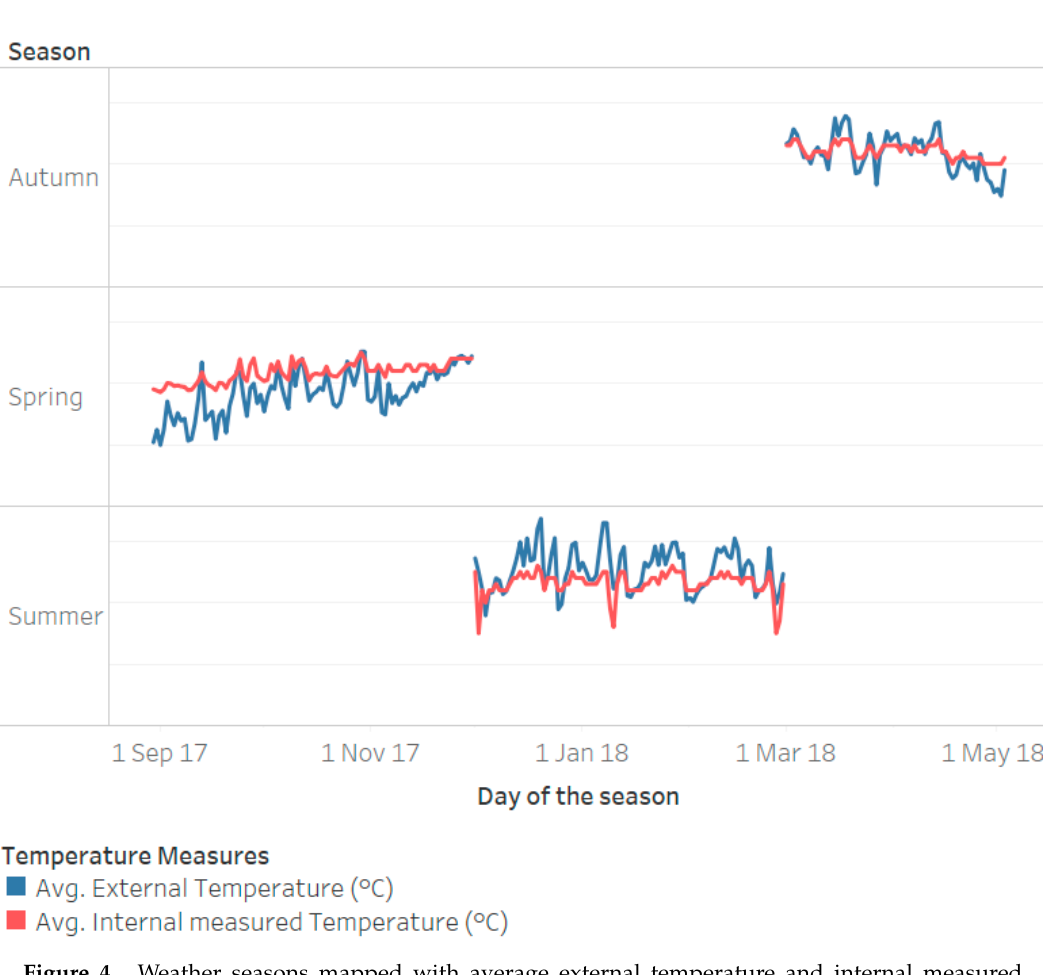
Figure 4. Weather seasons mapped with average external temperature and internal measured temperature in the greenhouse.